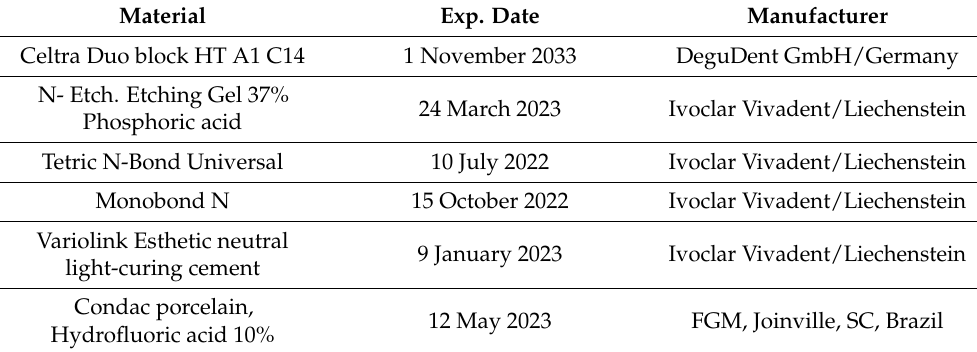
Table 1. Materials used in this